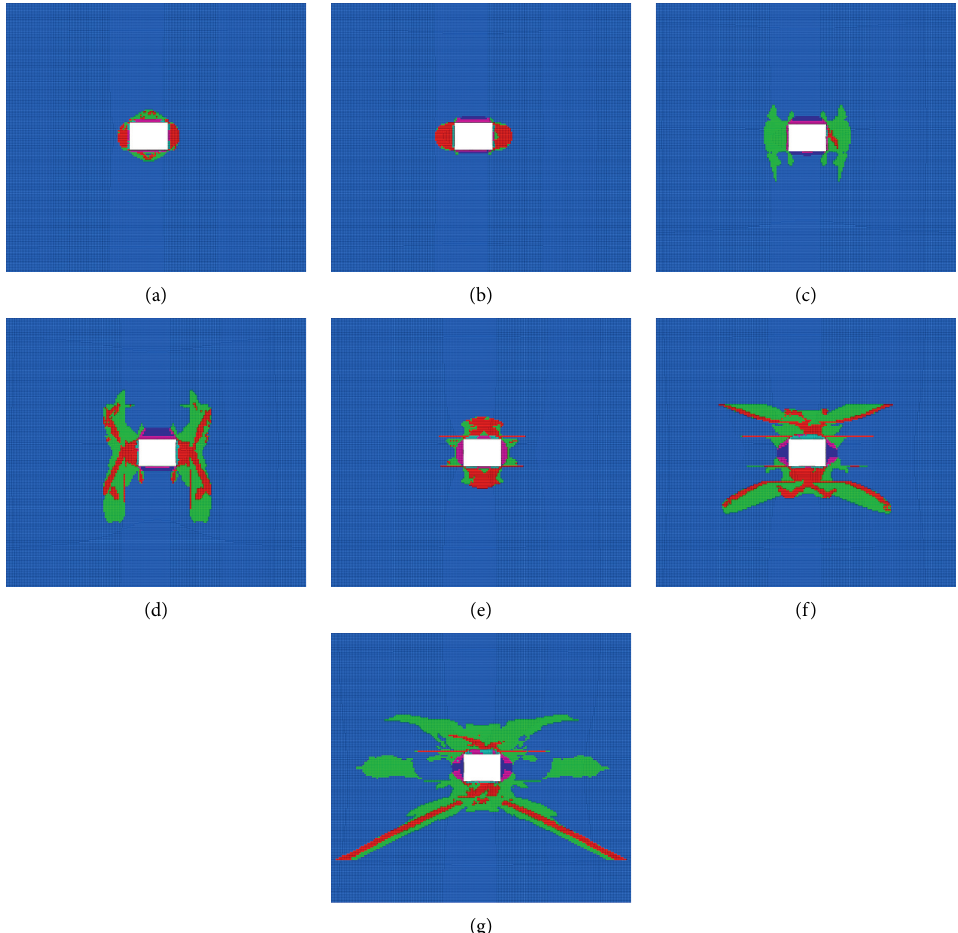
Figure 6: Morphology distributions of the surrounding rock plastic zone in the roadway influenced by stresses with different